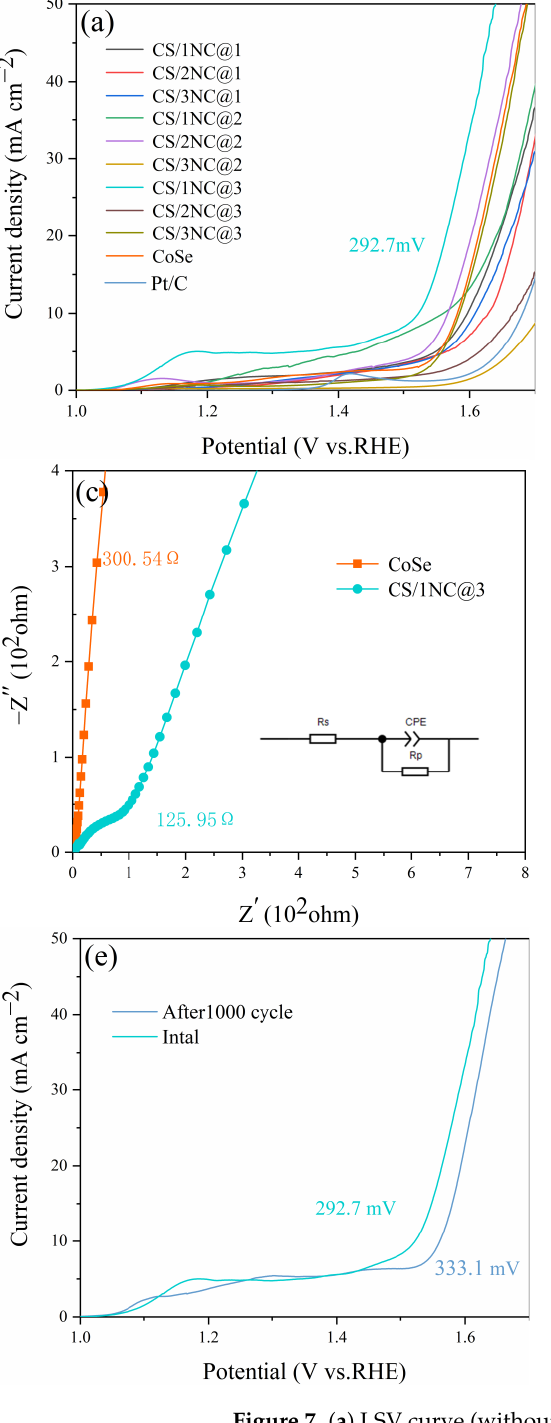
Figure 7. ( a ) LSV curve (without iR-corrected) and ( b ) Tafel slope of CS/yNC@X, ( c ) Nyquist plots of CS/1NC@3 and CoSe, ( d ) i – t curves of CS/1NC@3. ( e ) LSV curves of CS/1NC@3 in 1 M KOH solutions, respectively, before and after 1000 cycles.